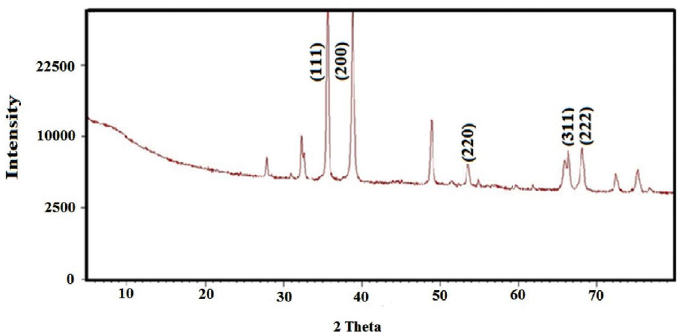
Fig. 6. XRD pattern of CdOnanopaticles.